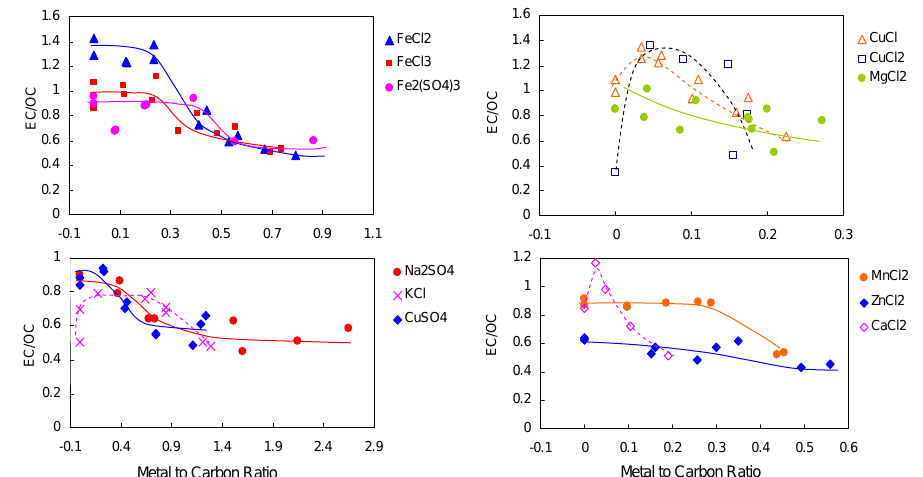
Fig. 5. EC/OC ratio as a function of metal to carbon ratio for metal-loaded diesel and the corresponding diesel reference samples.